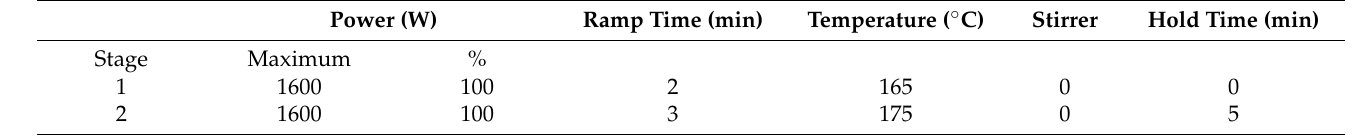
Table 3. Microwave digestion conditions.